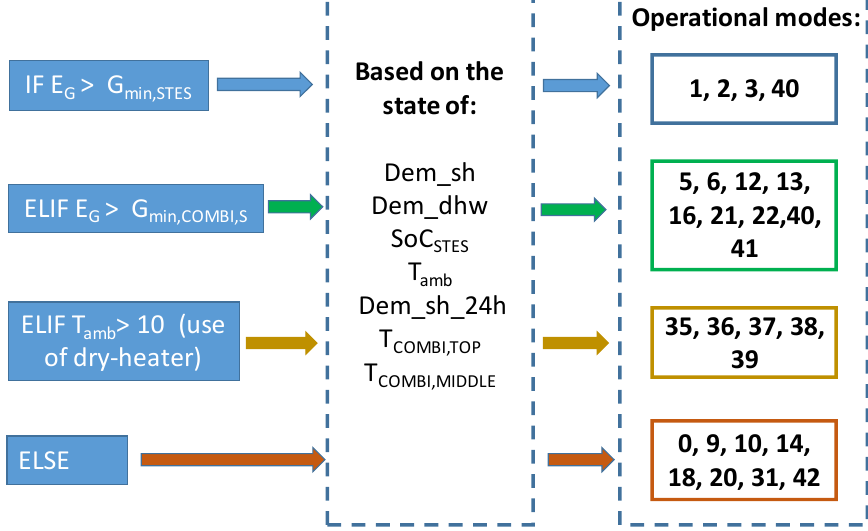
Figure A1. Simplified control policy for summer.